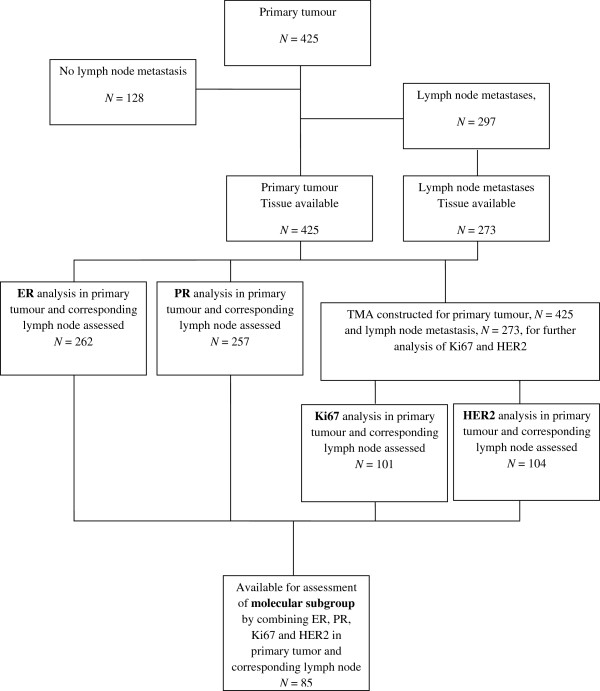
Flow chart of study cohort. Abbreviations: ER = Oestrogen receptor, PR = Progesterone receptor, HER2 = Human epidermal growth factor receptor 2, TMA = Tissue microarray.